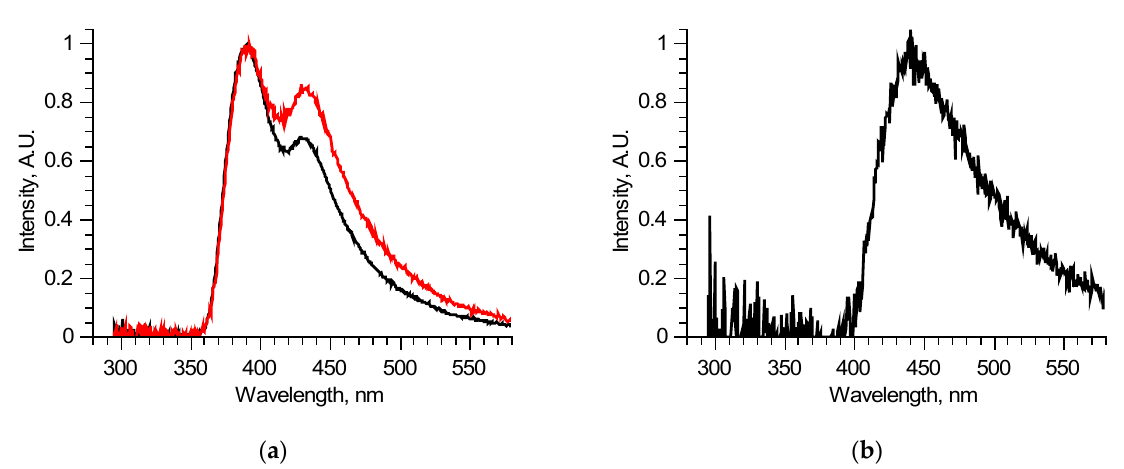
Figure 4. Analysis of separate excitation–emission matrix for 300–330 nm laser radiation wavelengths: spectra of two similar samples ( a ); differential spectrum derived from previous two spectra ( b ).